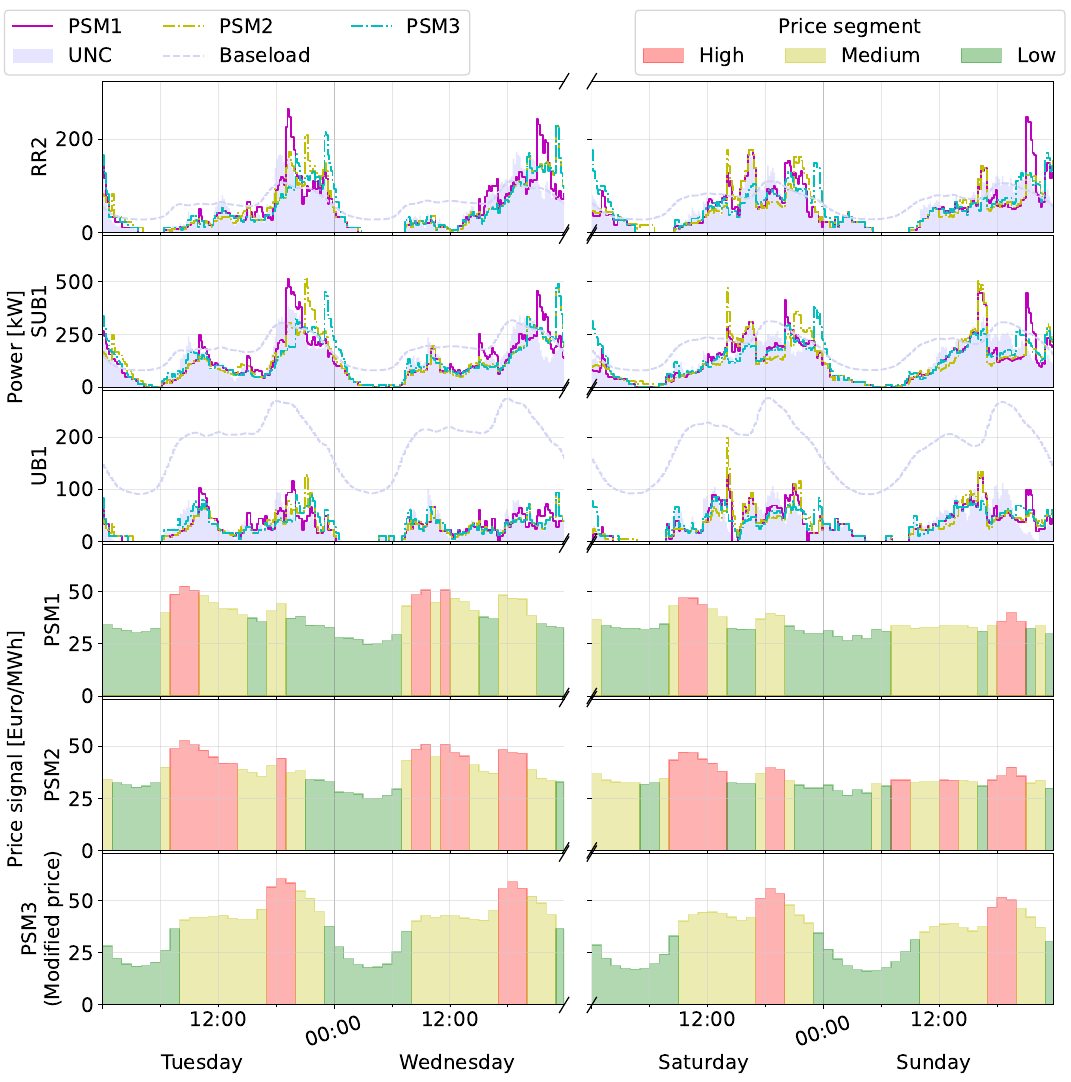
Figure 12. Comparison of total charging power under the three PSM study schemes for three grids (top three plots), with the corresponding price signals (bottom three